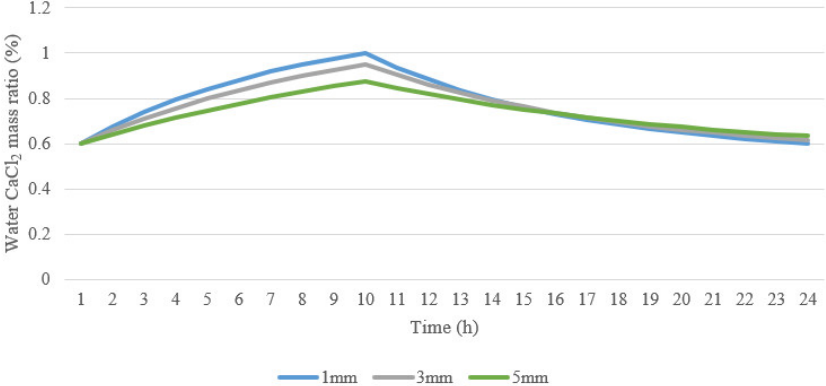
Figure 18. The effect of solution depth on absorption/desorption in fall.